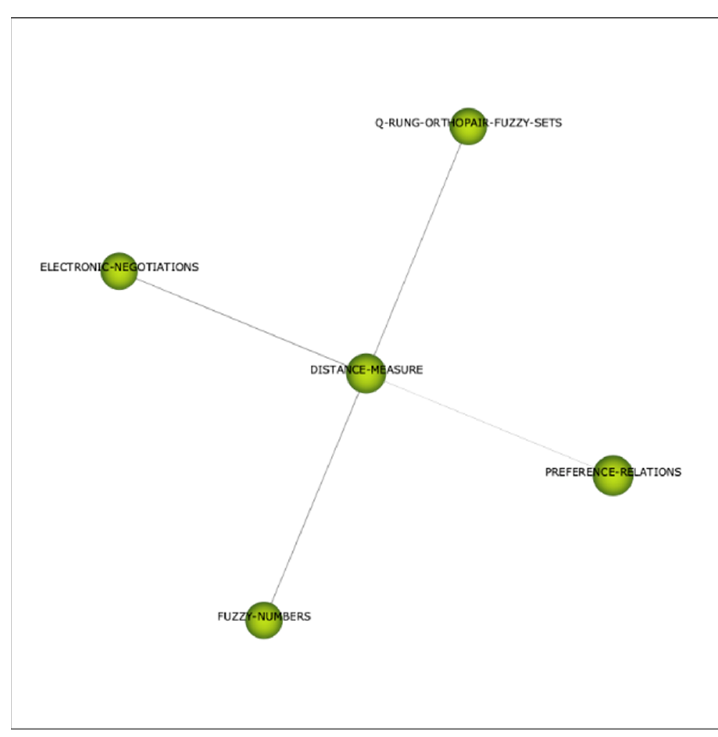
Figure A10. Distance-measure cluster network.